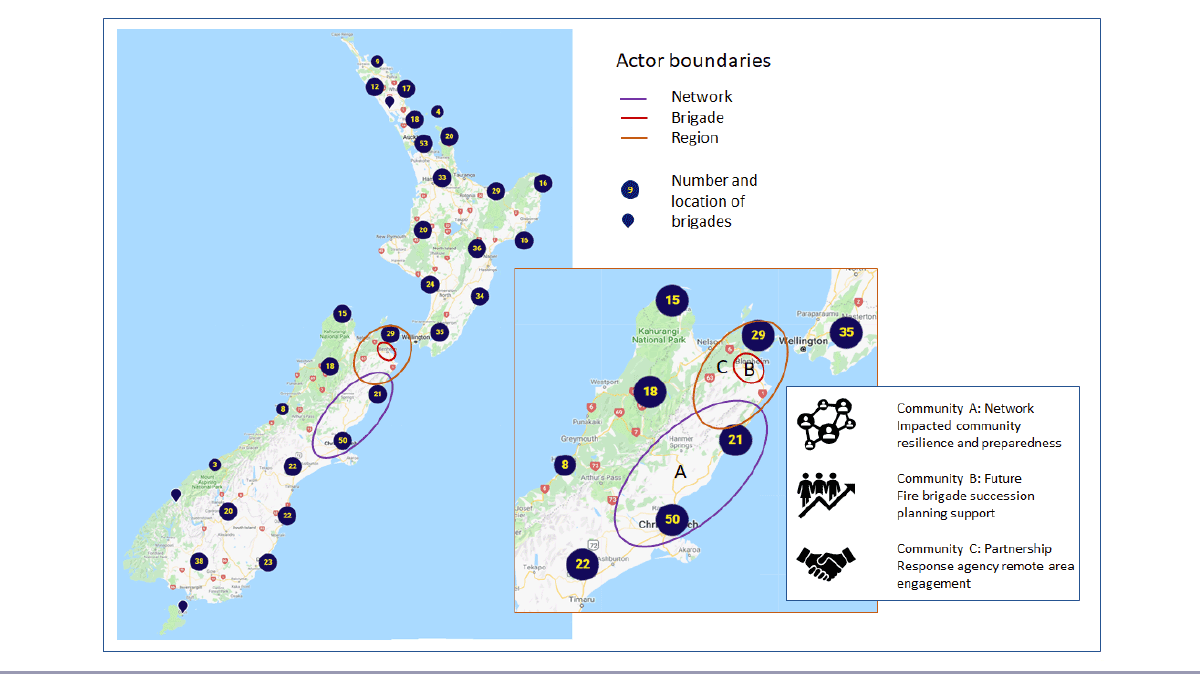
Fig. 3 . Co-inquiry actors’ boundaries overlaying a map showing the number and location of rural and urban fire brigades across New Zealand (source: FENZ 2019b). Inset study areas and resilience practice “community” sites in which actors were addressing